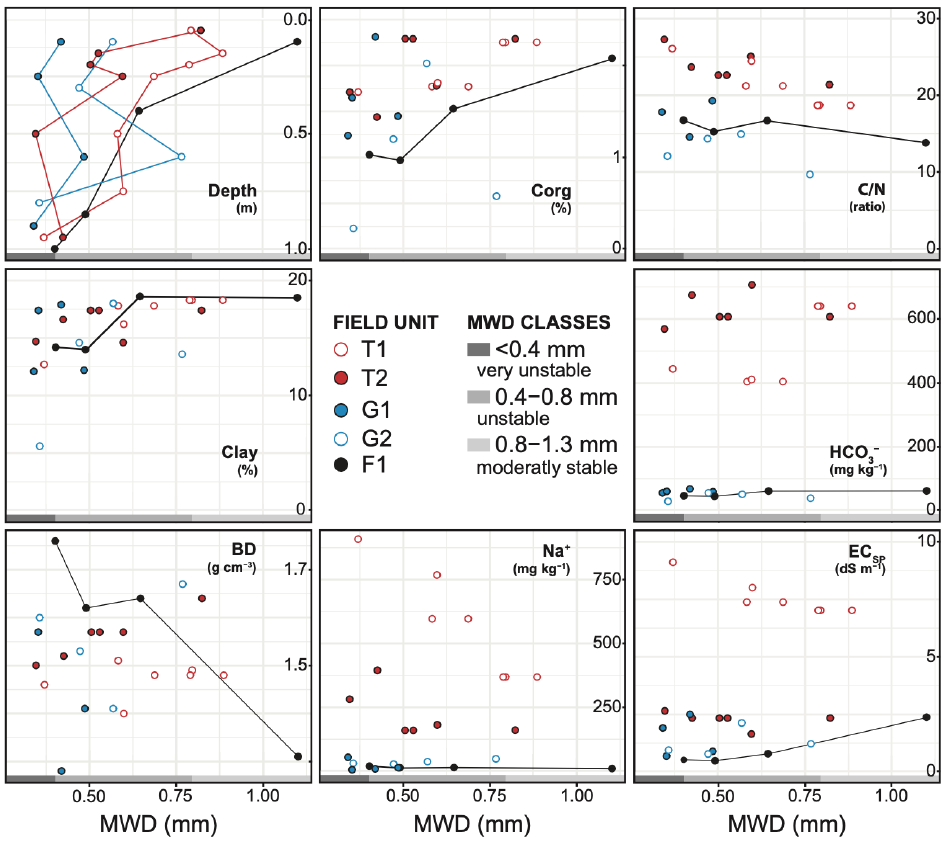
Figure 3. Mean weight diameter (MWD) values in relation to soil sampling depth (m) and prepon- derant soil properties of the sampled soil horizon.